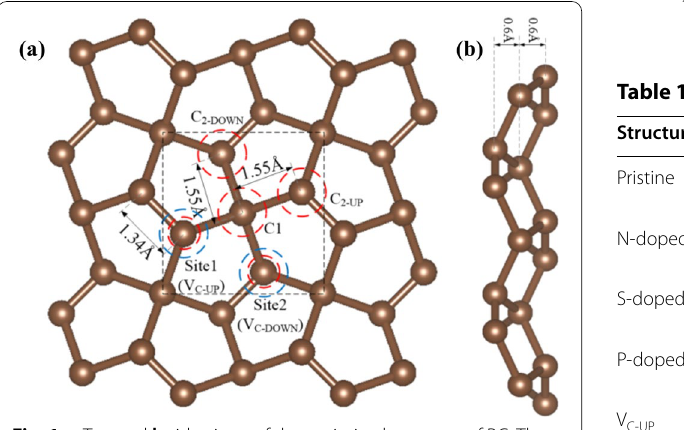
Fig. 1 a Top and b side views of the optimized structure of PG. The black dashed rectangle indicate unit cell, the blue dashed circles indicate two C vacancy sites, the red dashed circles indicate doping sites used in this paper